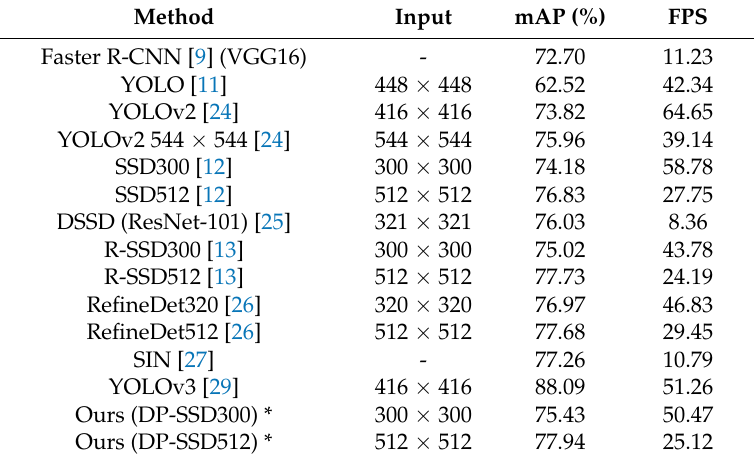
Table 6. Detection results between different methods on UA-DETRAC dataset. In addition to YOLOv3, DP-SSD512 outperforms all other methods on accuracy in real-time, and YOLOv2 achieves the highest speed of 64.65 FPS. * denotes using the new default box size in Table 2 or Table